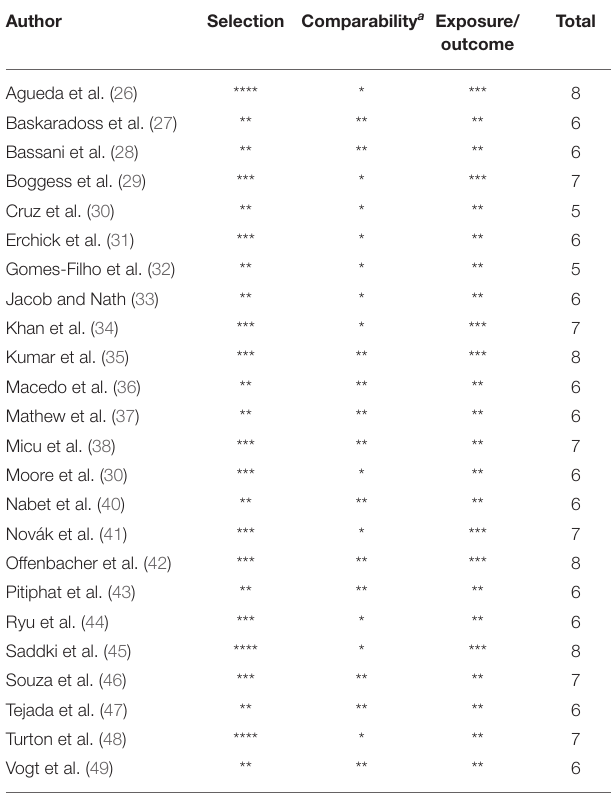
TABLE 2 | Assessment of risk of bias based on the Newcastle–Ottawa